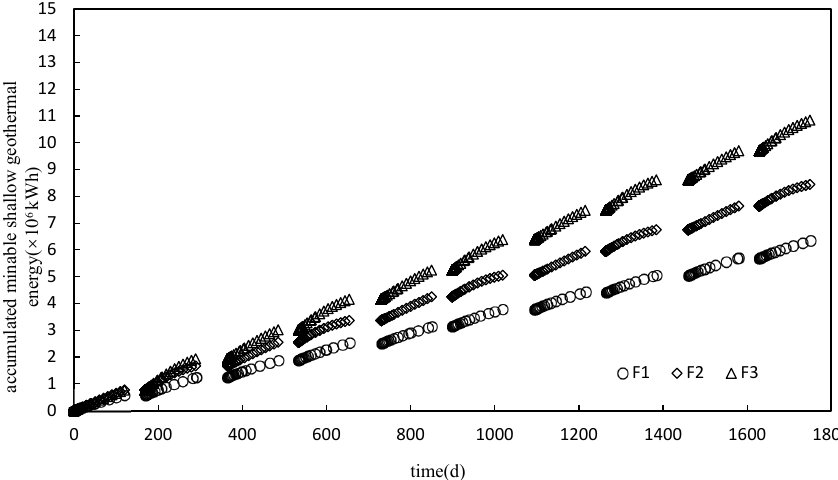
Figure 11. The accumulated minable shallow geothermal energy vs. time for the three operation schemes.